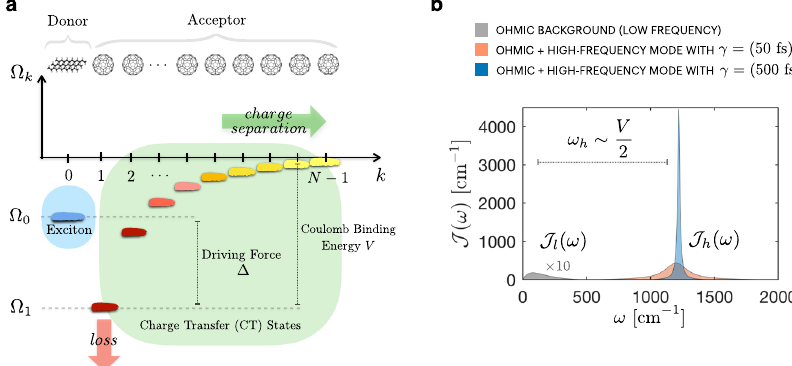
Fig. 1 Coulomb potential and vibrational environments. a Schematic representation of a one-dimensional chain consisting of a donor and ( N − 1) acceptors. The Coulomb binding energy of electron and hole is modeled by Ω k = − V / k with V = 0.3 eV for k ≥ 1. The energy gap between exciton and interfacial CT states is de fi ned as driving force Δ = Ω 0 − Ω 1 . b Vibrational environments consist of low-frequency phonon baths with room temperature energy scales ( k B T ≈ 200 cm − 1 ) and high-frequency vibrational modes. In this work, the low-frequency phonons are modeled by an Ohmic spectral density J l ð ω Þ with an exponential cutoff, while the high-frequency modes are described by Lorentzian spectral densities J h ð ω Þ centered at vibrational frequency ω h = 1200 cm − 1 (or 1500 cm − 1 ). The vibrational damping rate of the high-frequency modes is taken to be γ = (50 fs) − 1 or (500 fs) − 1 , as shown in red and blue, respectively, to investigate the role of non-equilbrium vibrational motion in long-range charge